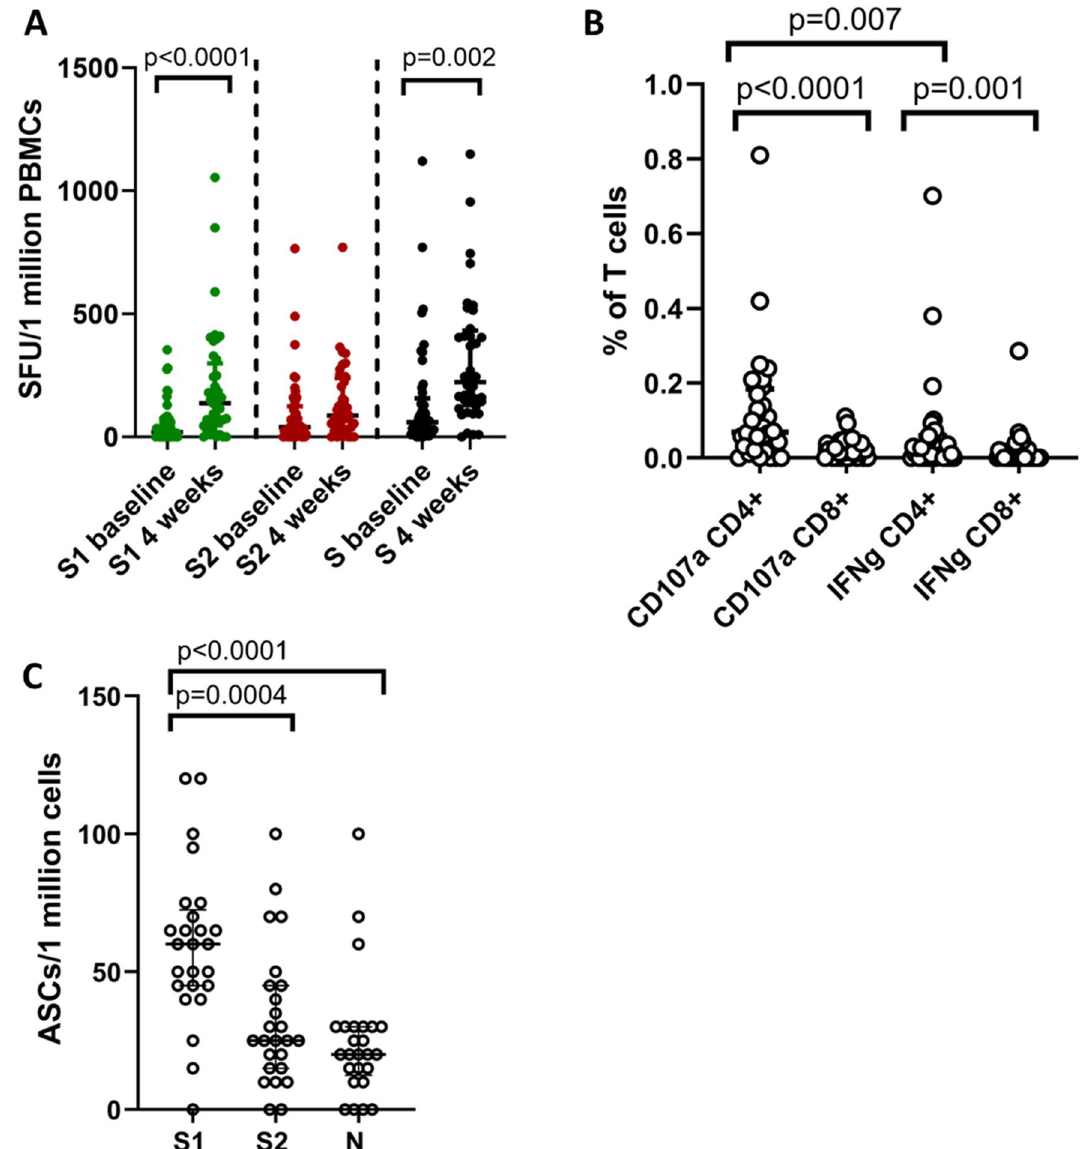
Figure 3. SARS-CoV-2 specific T cell and B cell responses in individuals who received the Gam-COVID-Vac. Ex vivo IFNγ ELISpot assays were carried out at 4 weeks (individuals who were vaccinated from Gam-COVID- Vac) (n = 40) in baseline uninfected individuals for overlapping peptides of spike protein, which were in two pools S1 and S2 ( A ). Intracellular cytokine staining was used to determine CD107a expression and IFNγ production at 4 weeks (n = 32) in CD4+ and CD8+ by flow cytometry ( B ). The number of antibody secreting B cells (ASCs) were determined at 4 weeks (n = 25) by doing B cell ELISpot assays ( C ). Wilcoxon matched pairs signed ranked test was used to find out the differences in ex vivo ELISpot responses for S1 and S2, and differences in CD107a expression and IFNγ production by CD4+ and CD8+ T cells and for B cell ELISpot assays. All tests were two sided. The error bars indicate the median and the interquartile neither S1 nor S2 correlated with the age of the individuals. Individuals had significantly higher (p < 0.0001) ex vivo IFNγ ELISpot responses to the S1 pool of peptides following the AZD1222 13 compared to the first dose of Gam-COVID-Vac, and for the S2 pool of peptides (p = 0.01). Intracellular cytokine assays (ICS) was carried out in a subset of the above individuals (n = 32) in whom IFNγ ELISpot responses were carried out due to limitations in the number of cells. A relative high frequency of CD107a expressing CD4+ (median 0.069, IQR 0.022 to 0.18% of CD4+ T cells) and CD8+ T cells (median 0.021, IQR 0 to 0.045% of CD8+ T cells) were seen with CD4+ T cells expressing significantly more CD107a (p < 0.0001) (Fig. 3B). IFNγ production was also predominantly by CD4+ T cells (median CD4+ T cells 0.01 vs 0 from CD8+ T cells), which was significant (p = 0.001). Spike protein specific CD4+ T cells expressed significantly more CD107a (p = 0.007) than IFNγ. No comparison could be carried out with AZD1222 as we had not carried out ICS for those who received the first dose of AZD1222 at the 4 weeks’ time point.